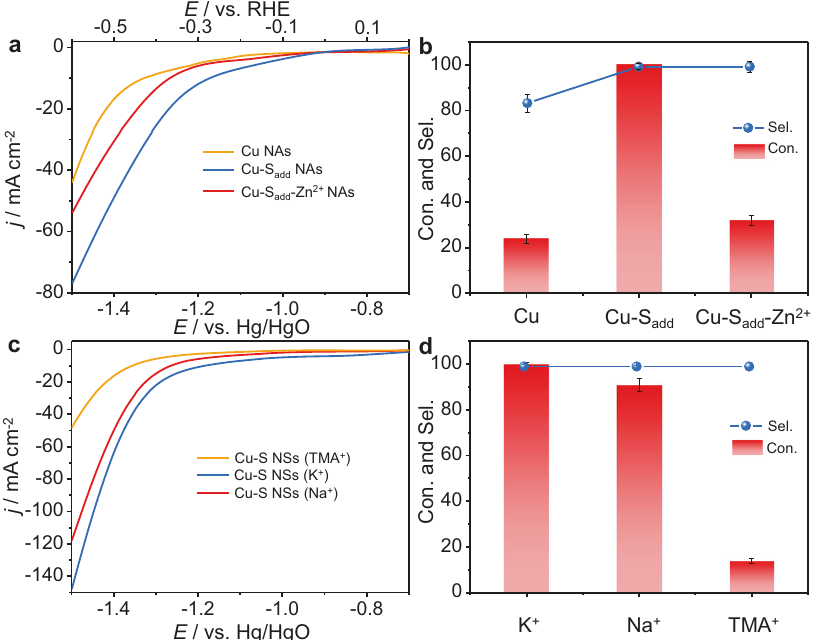
Fig. 5 The effect of sulfur ions and cations in the electrolyte. a LSV curves recorded in 1.0 M KOH without 1a , and b 1a Con. and 2a Sel. obtained with 0.1 mmol of 1a over different cathodes. c LSV curves recorded in 1.0 M MOH (M = Na + , K + , and TMA + ) electrolyte without 1a over Cu-S NSs cathode. d 1a Con. and 2a Sel. obtained in 1.0 M MOH (M = Na + , K + , and TMA + ) electrolyte with 1a over Cu-S NSs cathode. Error bars correspond to the SD of three independent